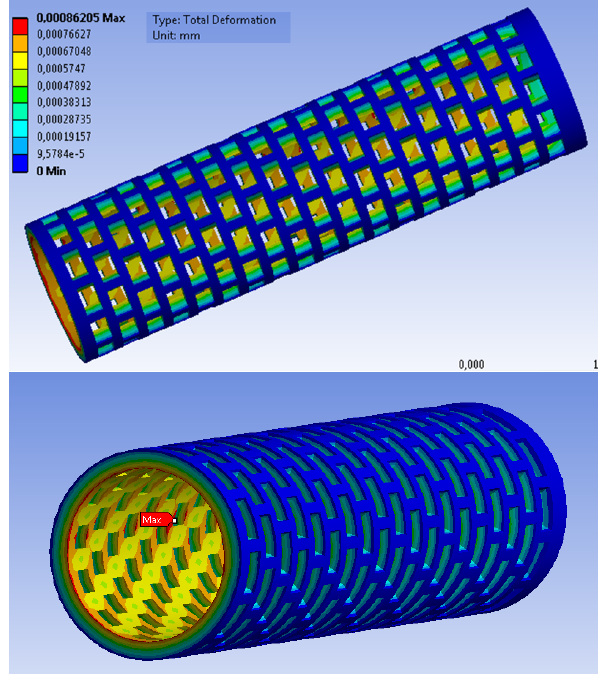
Figure 20. Distribution of deformation in the